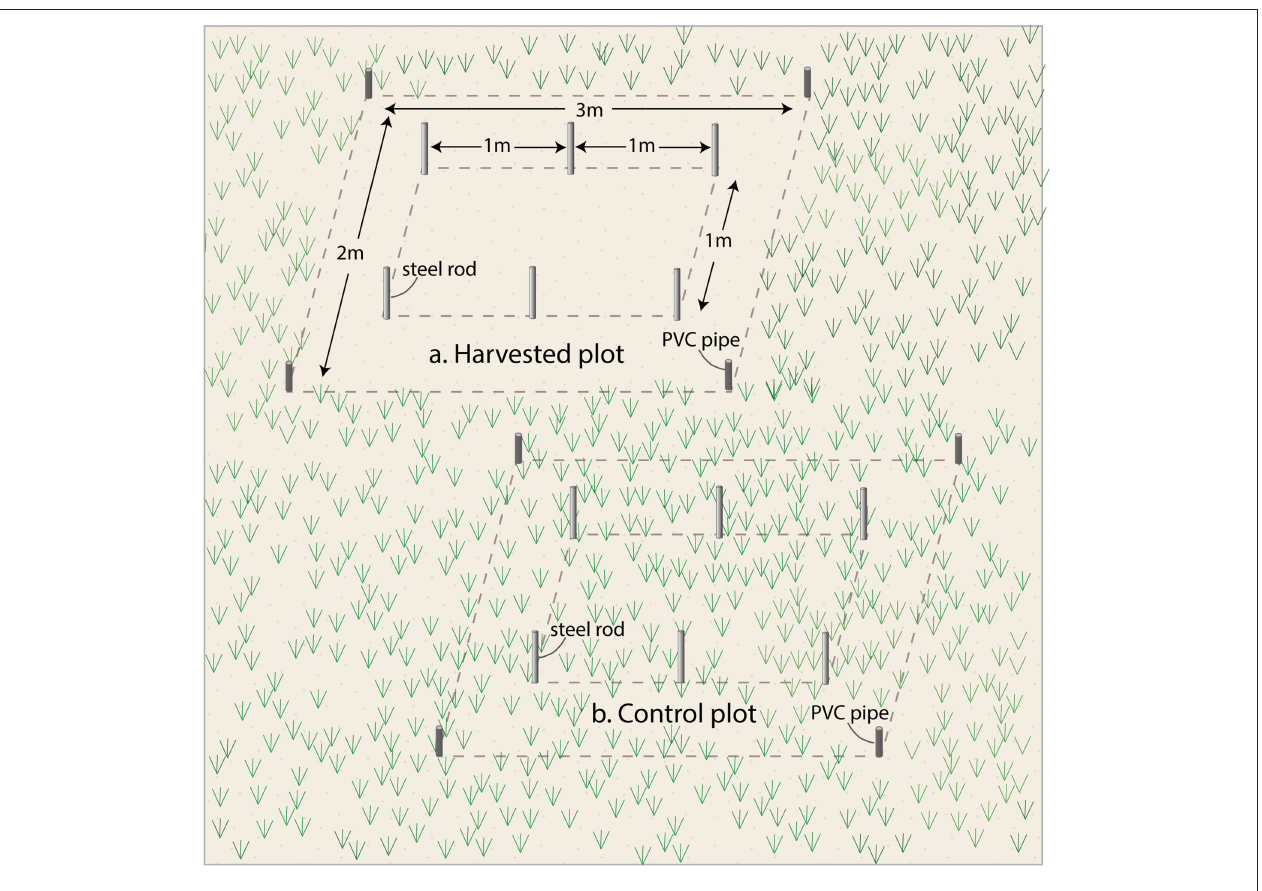
FIGURE 2 | Layout of the (A) Seagrass harvested and (B) control